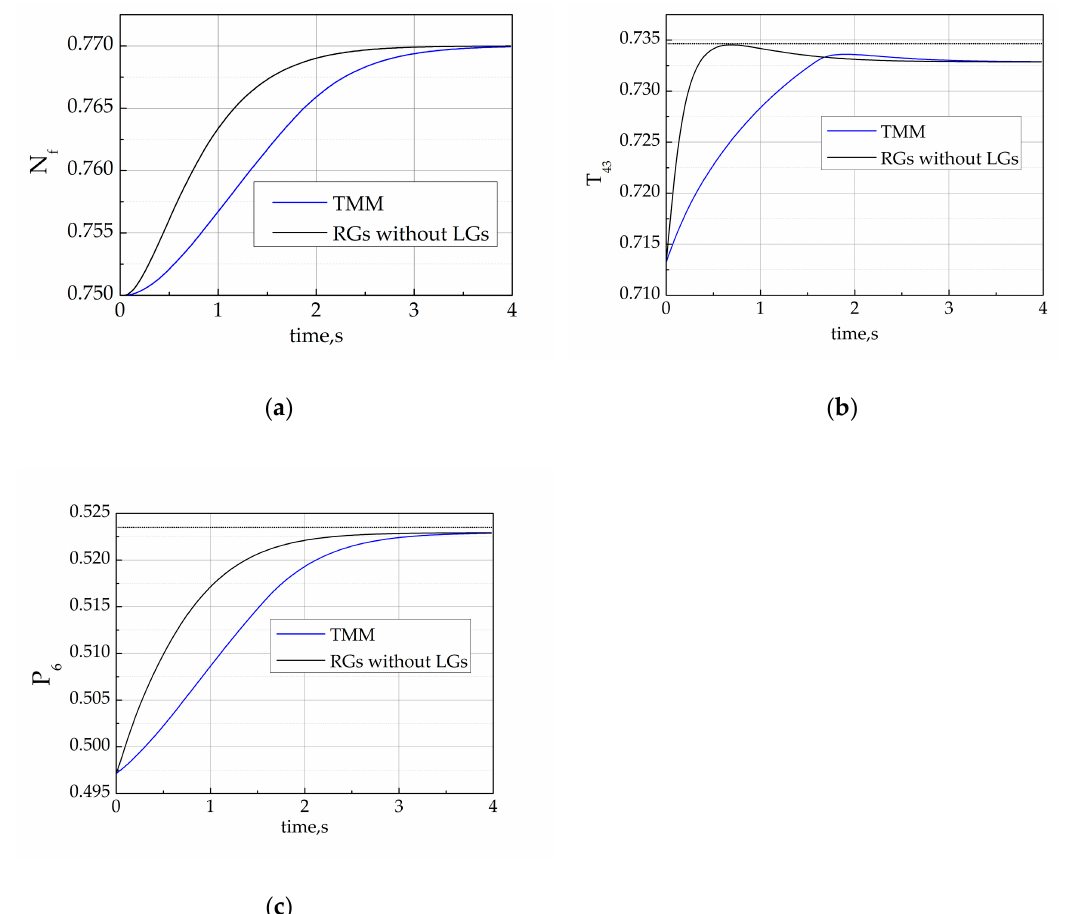
Figure 4. Comparison of original references governors (RGs) and traditional Min–Max structure. ( a ) The time history of fan speed (solid line); ( b ) the time history of the high-pressure turbine outlet temperature (solid line) and corresponding limit (dot) and ( c ) the time history of the low-pressure compressor outlet pressure (solid line) and corresponding limit (dot).